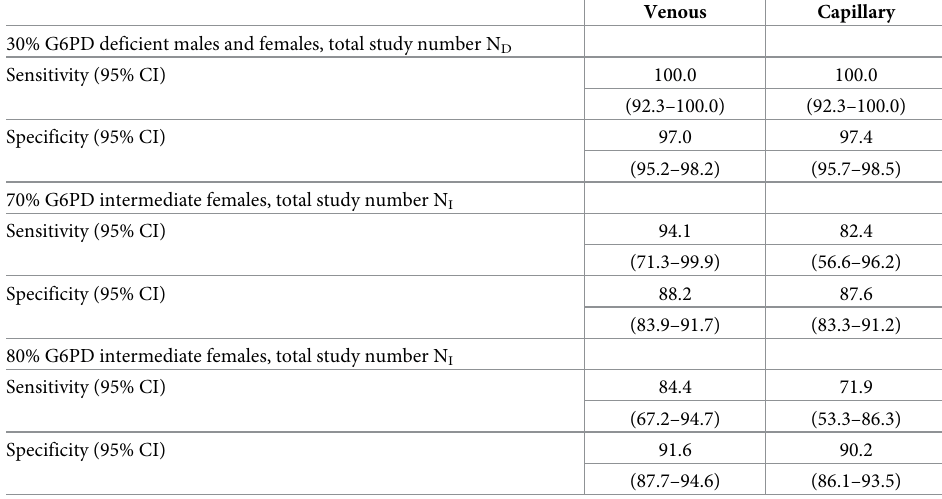
Table 4. Diagnostic performance of the STANDARD G6PD Test using the manufacturer’s thresholds compared with normalized spectrophotometric reference values, by specimen type.